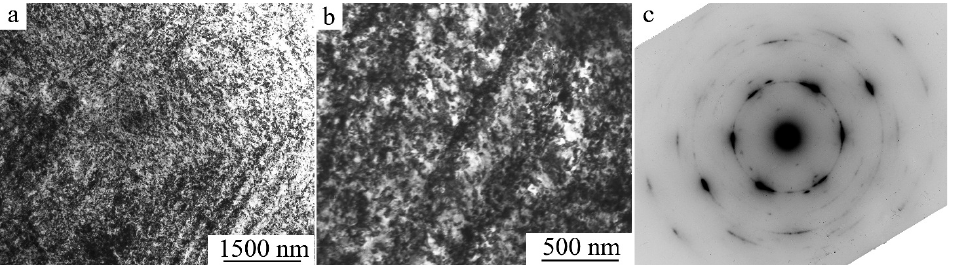
Figure 22. ( a , b ) Bright-field TEM images and ( c ) SAED pattern (with z.a. near [111] B 2 , SD 1.0 µ m) taken from the Ti 49 Ni 51 alloy after MPR to 30%.